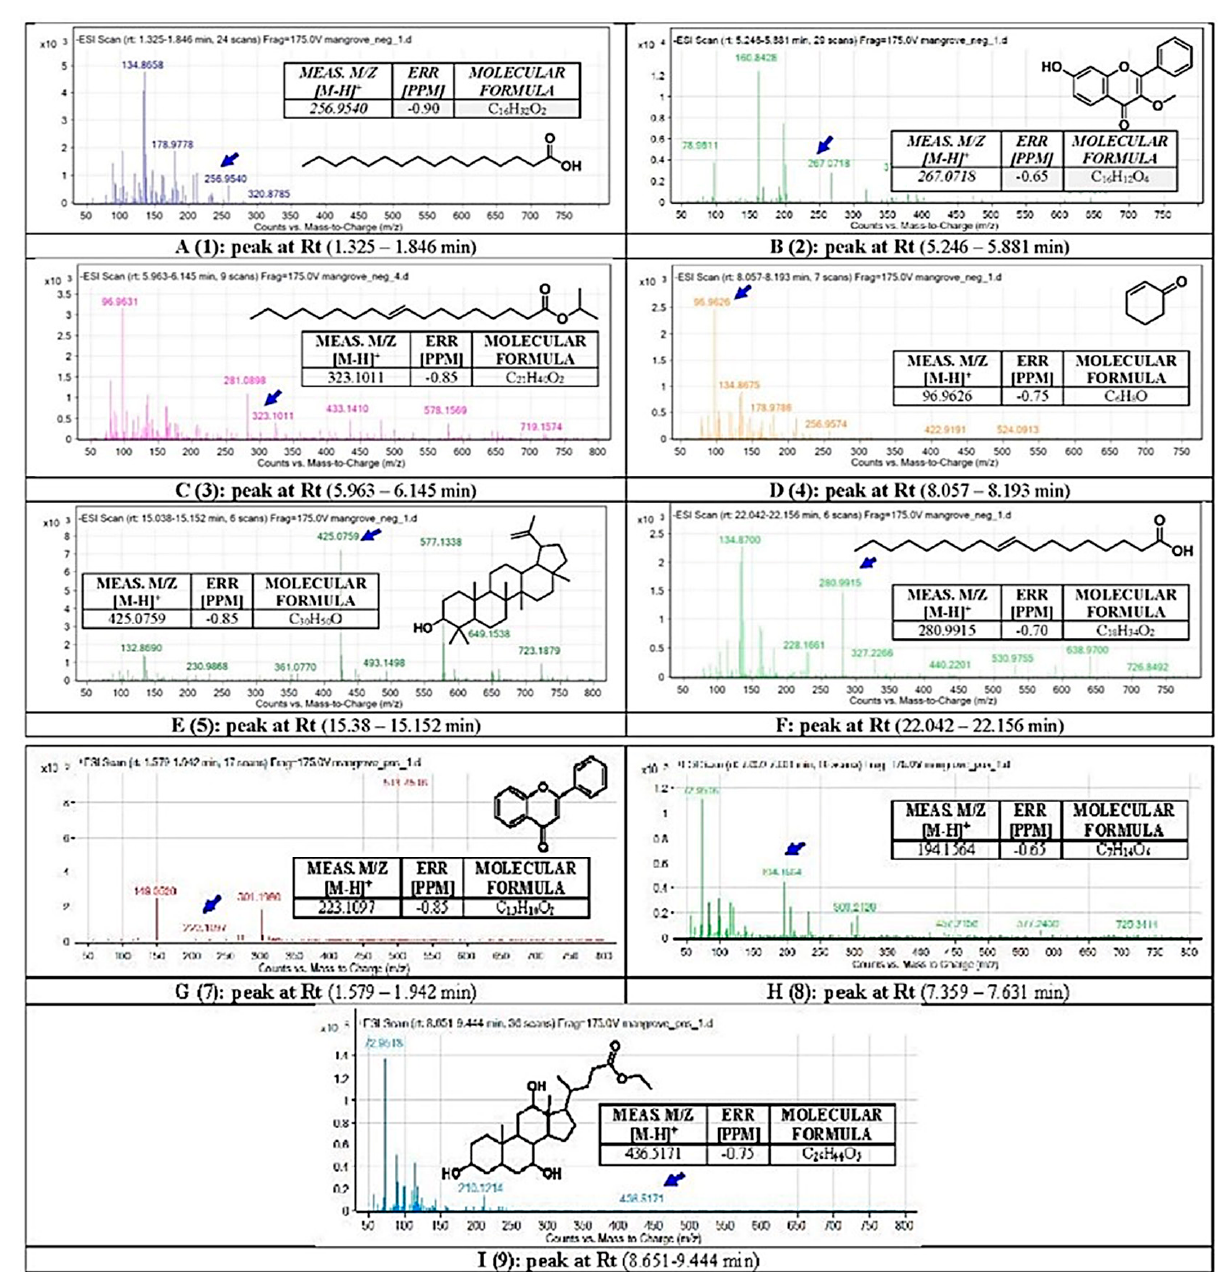
Figure 5. Chemical analysis using Liquid Chromatography with Mass Spectrometry (LC-QTOF). The secondary metabolites in BERM were tentatively identified as ( 1 ) n-Hexadecanoic acid, ( 2 ) 4H-1-benzopyran-4-one, 7-hydroxy-3-methoxy-2-pheyl, ( 3 ) Elaidic acid, isopropyl ester, ( 4 ) 2-Cyclohexen-1-one, ( 5 ) Lupeol, ( 6 ) Oleic acid, ( 7 ) Flavone, ( 8 ) O-methyl-d-glucose, and ( 9 ) Ethyl iso-allocholate. Means m / z implies measured m / z